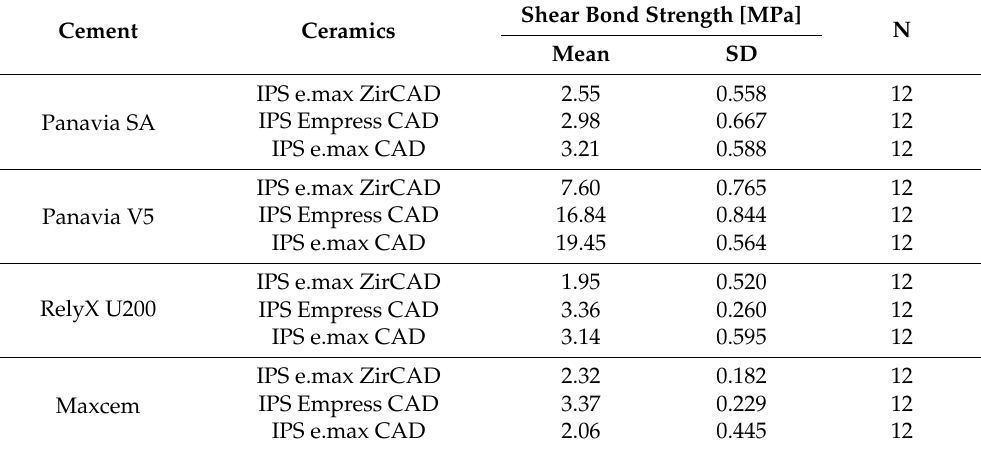
Descriptive statistics for the examined samples; N–number of samples, SD–standard deviation.